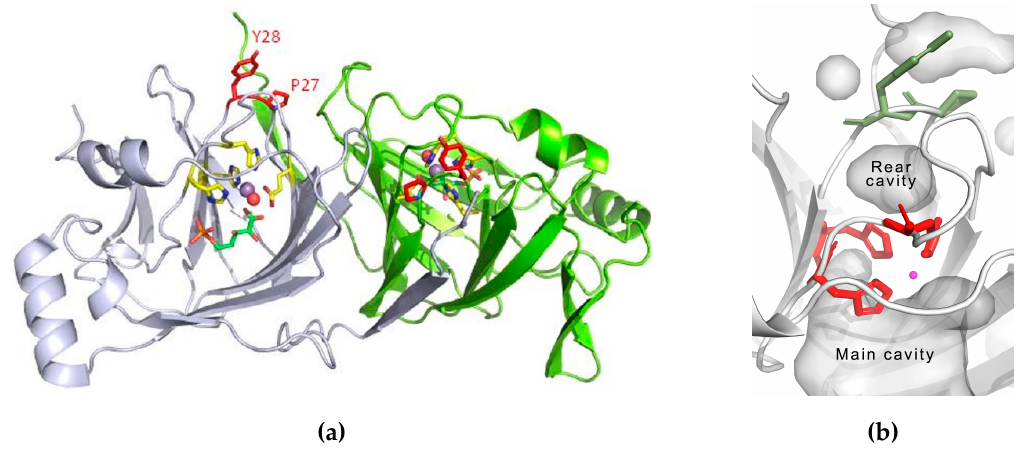
Figure 2. Structure details of wild-type PfPGI. ( a ) Cartoon representation of the dimer (white and green subunits) of the wild-type PfPGI Mn 2 + / 5PAA 3D structure (Protein Data Bank (PDB) code: 1X7N). The correlated amino acid pair “PY” is indicated in red. Shown in yellow are those residues involved in manganese (purple sphere) binding, including a water molecule (red sphere). The inhibitor 5-phospho-D-arabinonate (5PAA) is shown as a stick model (green). ( b ) Location of main and rear cavities in PfPGI structure. Histidines 88, 90, and 136 separating main and rear cavities are shown as red sticks, Pro132 and Tyr133 separating rear-side cavity from solvent as green sticks, Mn 2 + ion as